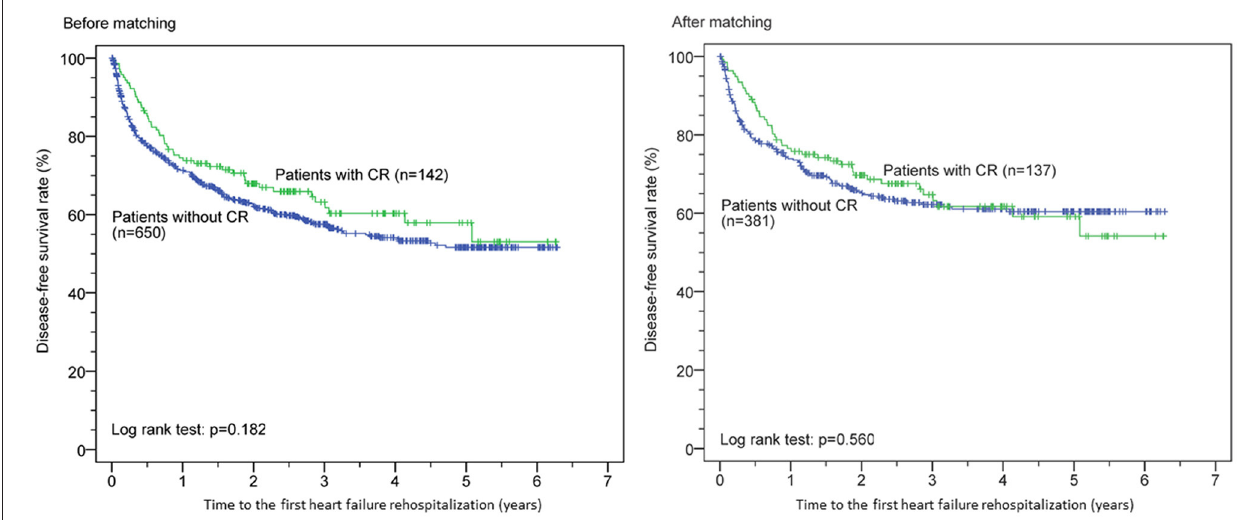
FIGURE 2 | Cardiac rehabilitation (CR) and time to the first heart failure rehospitalization before and after propensity score matching.